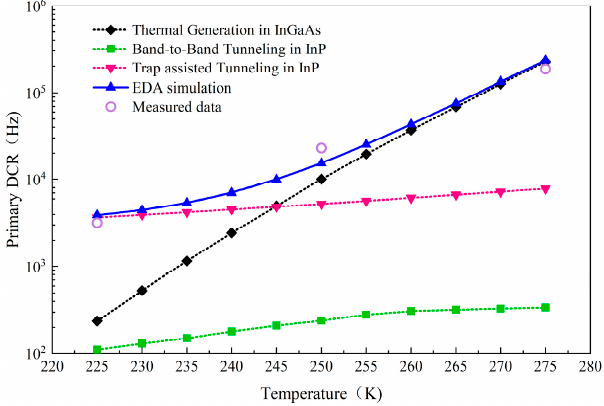
Figure 6. Simulation results of the temperature dependence of the primary DCR ( V ex = 5 V). Figure 7 shows the simulated total DCR variation with the gate-OFF time (which corresponds to the dead time) at 225 K. Although there is a little gap at the long gate-OFF time, the simulation and the measured results are in reasonable agreement. When a short gate-OFF time was set, the total DCR increased because of after-pulsing. The after-pulsing was apparently visible at a higher excess bias when the gate-OFF time was smaller than 10 µ s, and it could be obtained by subtracting the primary dark counts from the total DCR. The shadow areas in the figure show the contribution of after-pulsing to the total